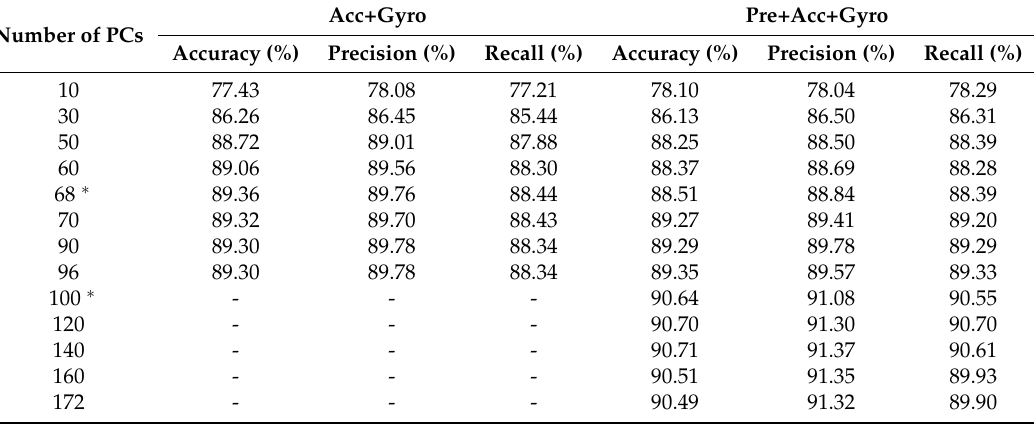
Table 8. The effect of the number of PCs on classification performances of two and three different types of